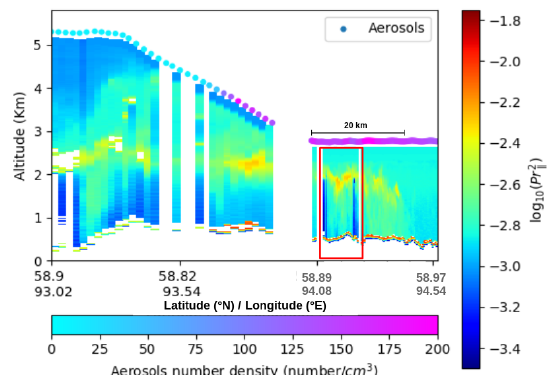
Fig. 6: Vertical cross-section of aircraft log on July, 19 2013. Calibration constant is 491724 ± 10%. Grimm aerosol concentrations in parti- cle.cm -3 are shown at the aircraft